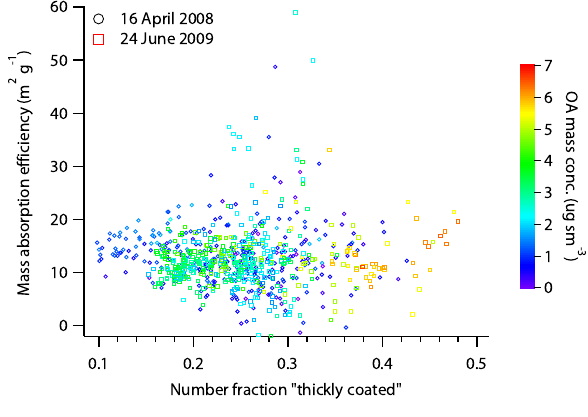
Fig. 7. Refractory black carbon (rBC) mass absorption efficiency calculated from SP2 measured rBC mass concentrations and cor- rected PSAP-measured light absorption coefficients at λ = 550 nm and standard temperature and pressure as a function of the number fraction of thickly coated particles measured by the SP2. Points are shaded by organic aerosol mass concentrations measured by the AMS. Each day is plotted using a different symbol. Only measure- ments inside the boundary layer are